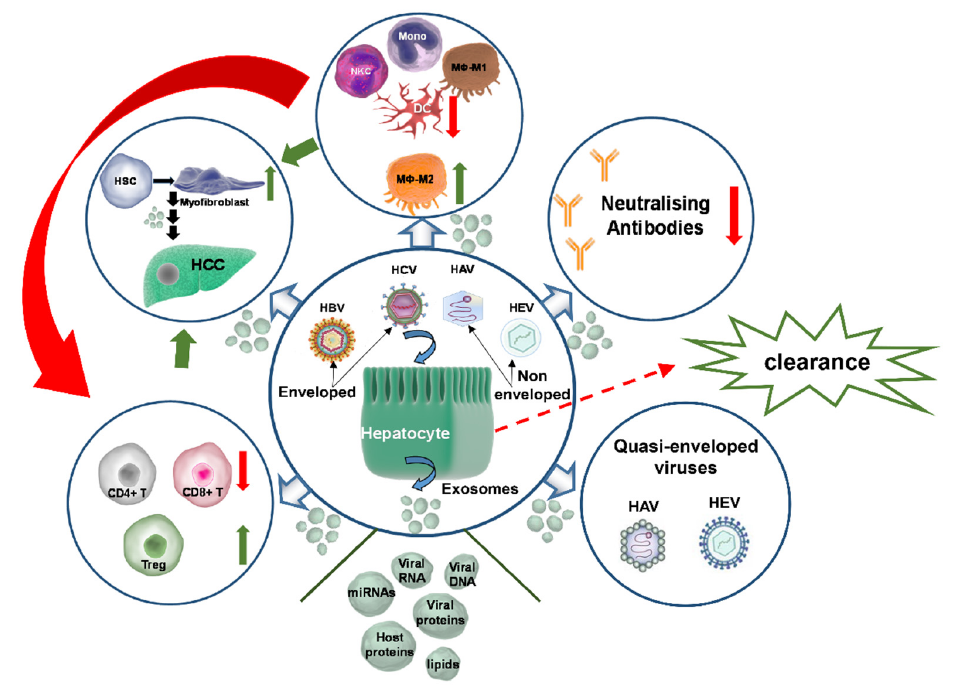
Figure 2. Enveloped (HCV, HBV) and non-enveloped hepatitis (HAV, HEV) viruses infect primarily hepatocytes. The non-enveloped viruses may potentially use the exosomal biogenesis pathway for egress, producing quasi-enveloped virions (bottom-right circle). All hepatitis viruses can exploit exosomes to egress and transfer their genetic material, together with viral proteins involved in replication, into permissive cells, as the exosomes grant them invisibility from host neutralising antibodies (top-right circle). However, if the host mounts efficient immune responses, as in the case of HAV and HEV, the viruses are cleared at the acute phase of infection (dashed red arrow). For viruses that achieve persistence, such as HCV and HBV, exosomes may be used for independent or consecutive (red arrow on the left) deregulation of the innate (top circle) and adaptive immune responses (bottom-left circle), leading to sustained immune evasion, immunotolerance, and immunosuppression. The exosomal cargo consists of immunoregulatory proteins, lipids, enzymes, and small RNAs (truncated cone) and may exert its immunoregulatory capacity on all immune cells, down-regulating antiviral responses whilst up-regulating tolerance. Eventually, constant immune response dysfunction, together with misdirected signalling and deregulated cellular homeostasis, lead to initiation of liver fibrosis and promote malignant transformation and HCC development (top-left circle). Key: Mono: monocytes; M φ : macrophages; CD4+/CD8+ T: T-cells; red arrows: inhibitory action; green arrows: inducing action.